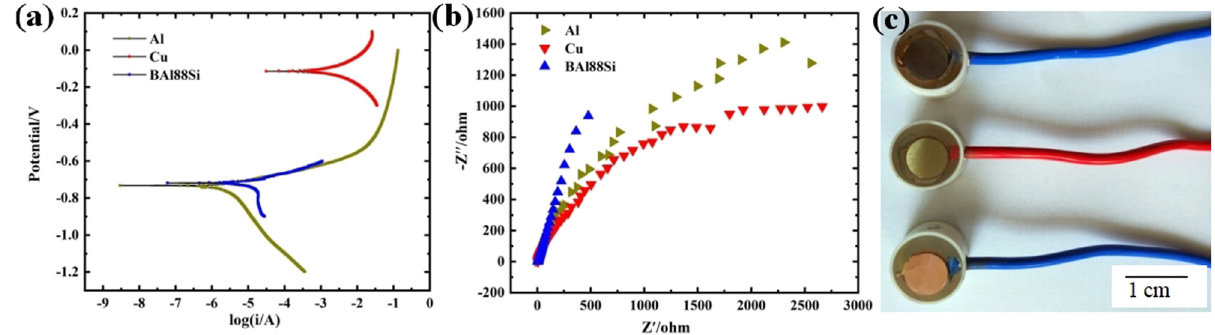
Figure 10: Image of electrochemical results: ( a ) Tafel polarization curves of the solder and base metal; ( b ) electrochemical impedance spectroscopy of the solder and base metal, and ( c ) diagram of samples for electrochemical